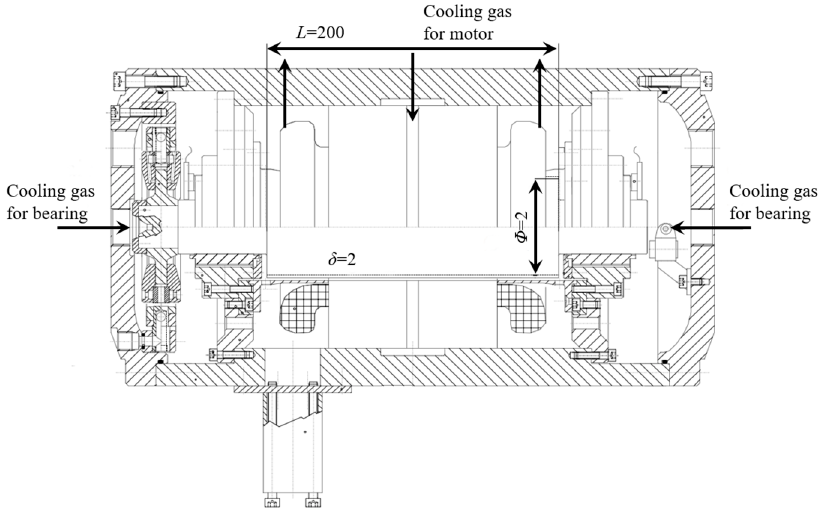
Table 1. Dimensions of outer radius R o , gap width δ , and radius ratio η .